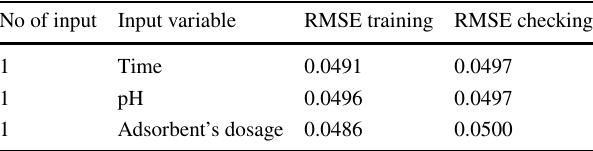
Table 1 One-input variable ANFIS (exhaustive search) for chromium(VI)